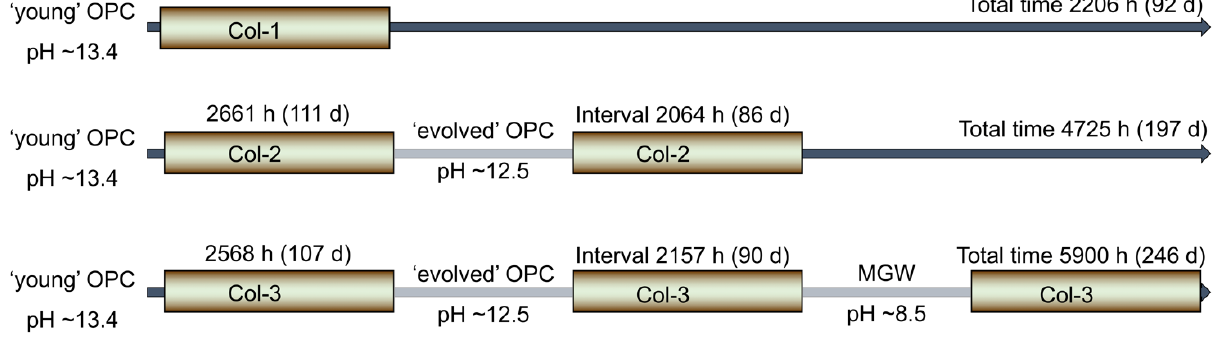
Figure 2. Interval and total times for the sequential column experiments with Toki granite reacting with OPC leachates and then groundwater.